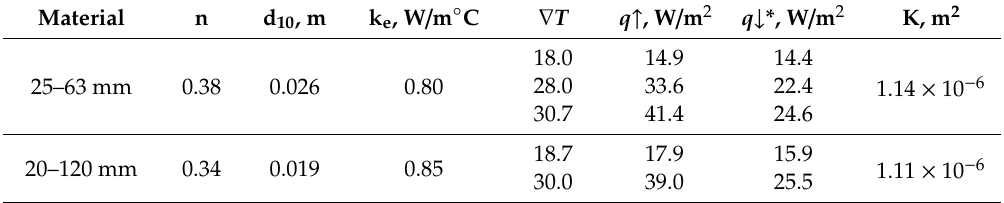
Table6. Samplecharacteristics,